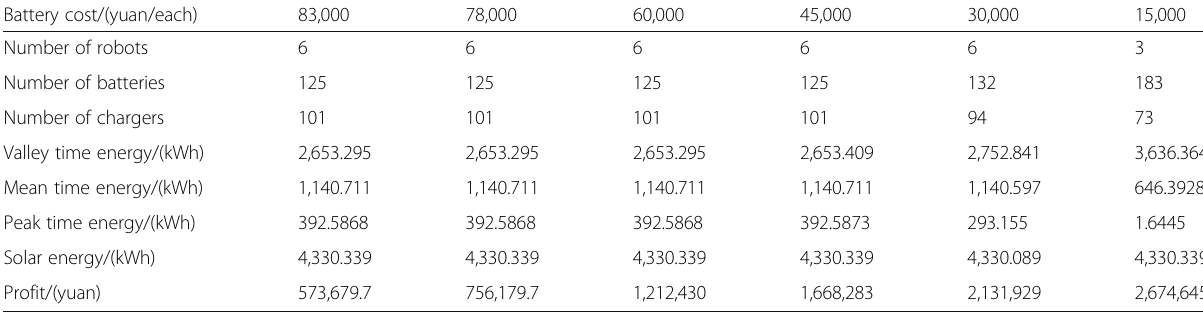
Table 4 The optimal configurations and energy consumptions of BSS with different costs of battery Battery